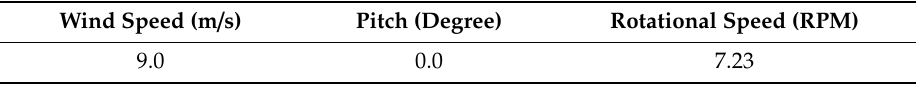
Table 2. Operational parameters of the DTU 10MW RWT